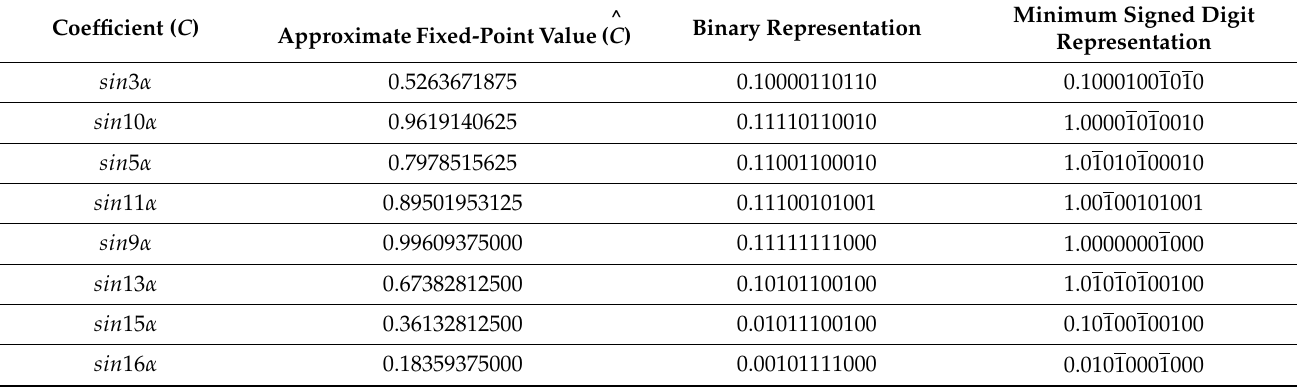
Table 2. Transform coefficients using minimum signed digit